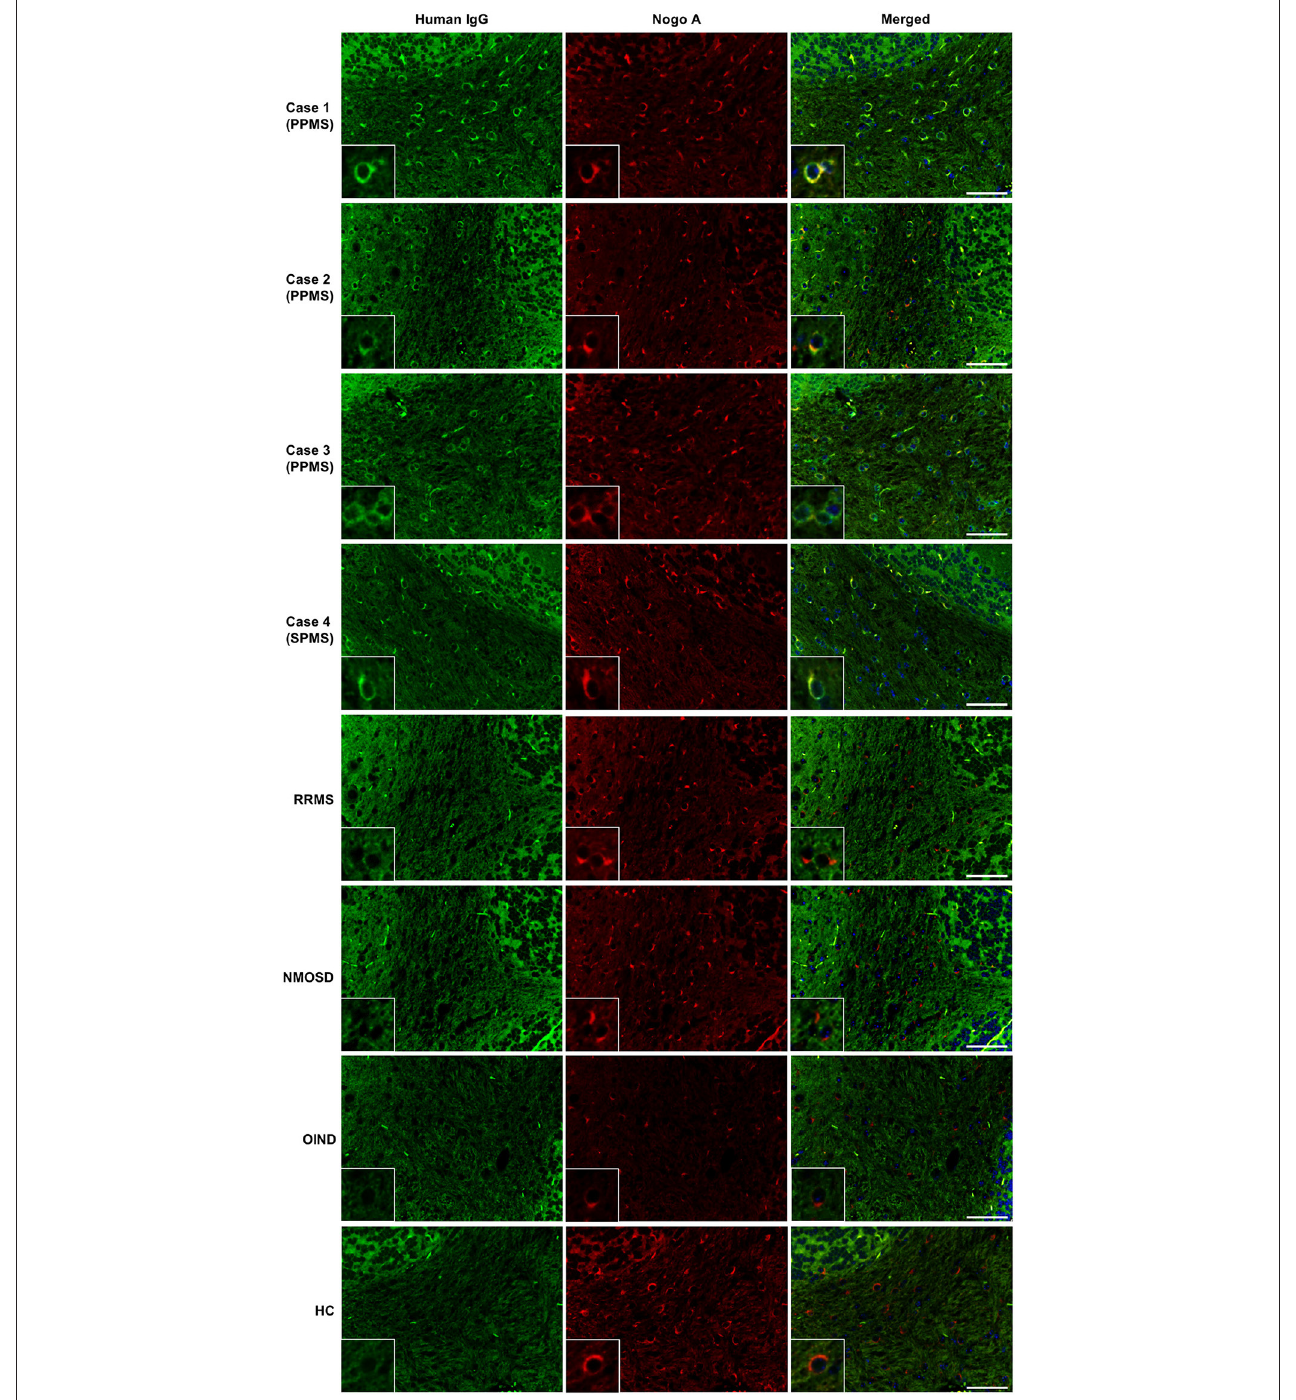
FIGURE 1 | Screening for serum autoantibodies against oligodendrocytes in patients with MS. IgGs (green) from three PPMS patients (Cases 1–3) and one SPMS patient (Case 4) bound to Nogo A-positive oligodendrocytes (red) in mouse cerebellum, whereas control IgGs from one representative RRMS patient, one representative NMOSD patient, one representative OIND patient with neuro-Behçet’s disease, and one representative HC showed no significant immunoreactivity toward Nogo A-positive oligodendrocytes. Nuclei were counterstained with 4 ′ ,6-diamidino-2-phenylindole (DAPI) (blue). Scale bars: 50 µ m. ANA, antinuclear antibody; CNS, central nervous system; HC, healthy control; IgG, immunoglobulin G; MS, multiple sclerosis; NMOSD, neuromyelitis optica spectrum disorders; OIND, other inflammatory neurological disorder; PPMS, primary progressive multiple sclerosis; RRMS, relapsing–remitting multiple sclerosis; SPMS, secondary progressive multiple